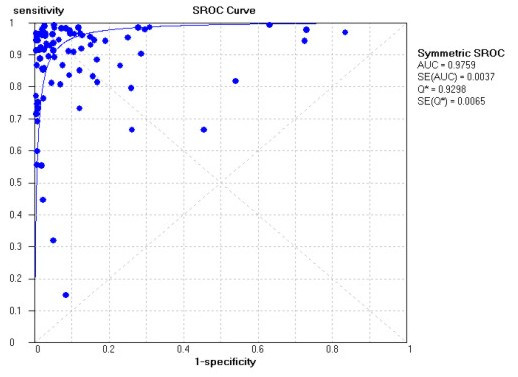
Summary Receiver Operative Curve (SROC) for all studies. Each solid circle represents each study in the meta-analysis. The regression line summarizes the overall diagnostic accuracy. Area under the curve (AUC) = 0.97.